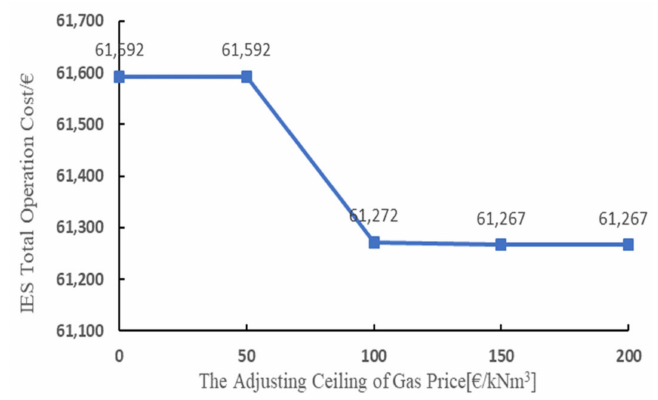
Figure 4. The total operating cost of the IES under di ff erent gas price adjustment limits.